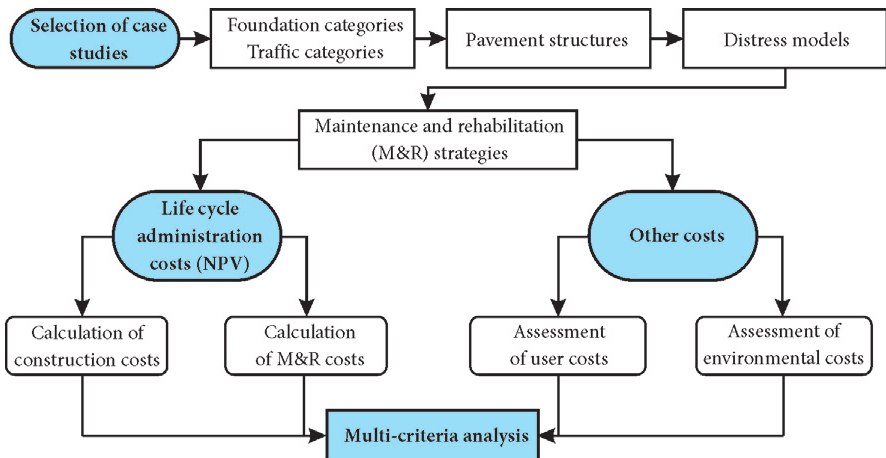
Fig. 1. Main activities of the proposed